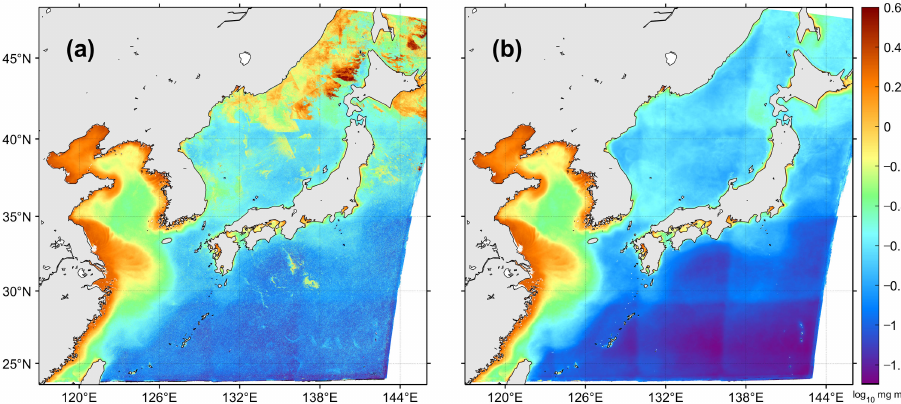
Figure 12. Yearly composite map of chlorophyll- a concentration from ( a ) GOCI level-2 data and ( b ) reprocessed data after the speckle-removal process for the period of